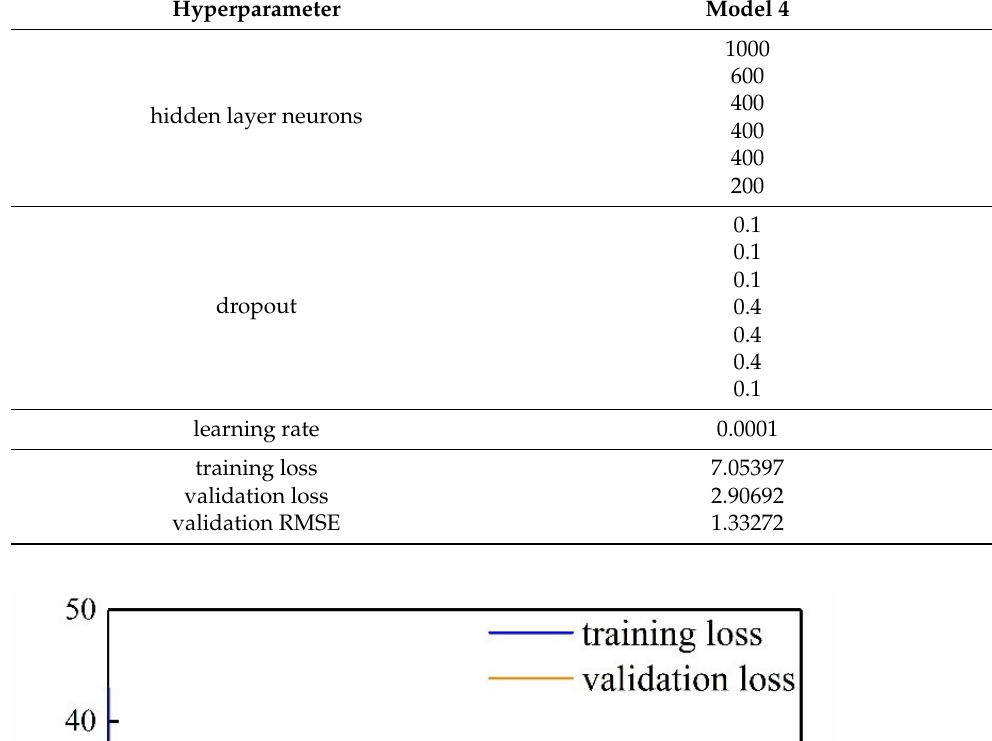
Figure 5. Loss curve of model 1.